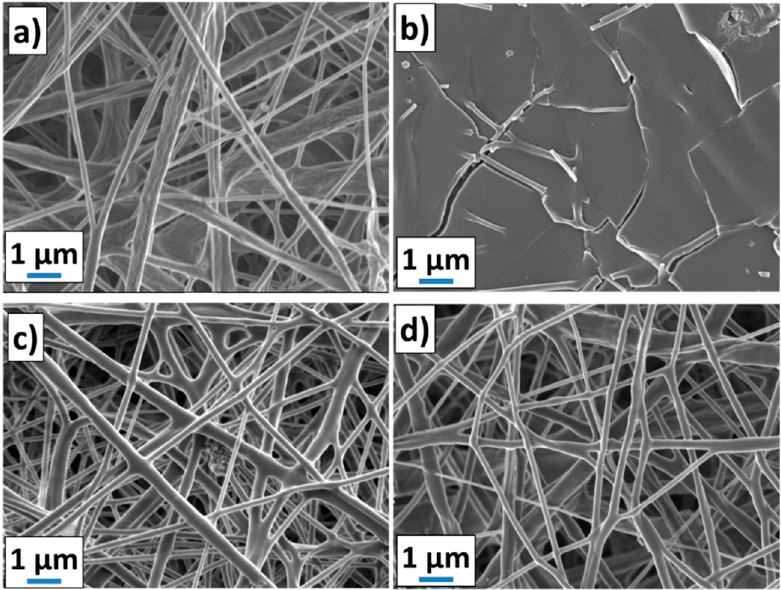
Figure 1. SEM micrographs (magnification 10,000 × ) of samples PCL/PEO-ref ( a ) PCL/PEO-Ti0.5- Ag-15 kV ( b ), PCL/PEO-Ti0.3-Ag-8 kV ( c ) and PCL/PEO-Ti0.3-Ag-5 kV ( d